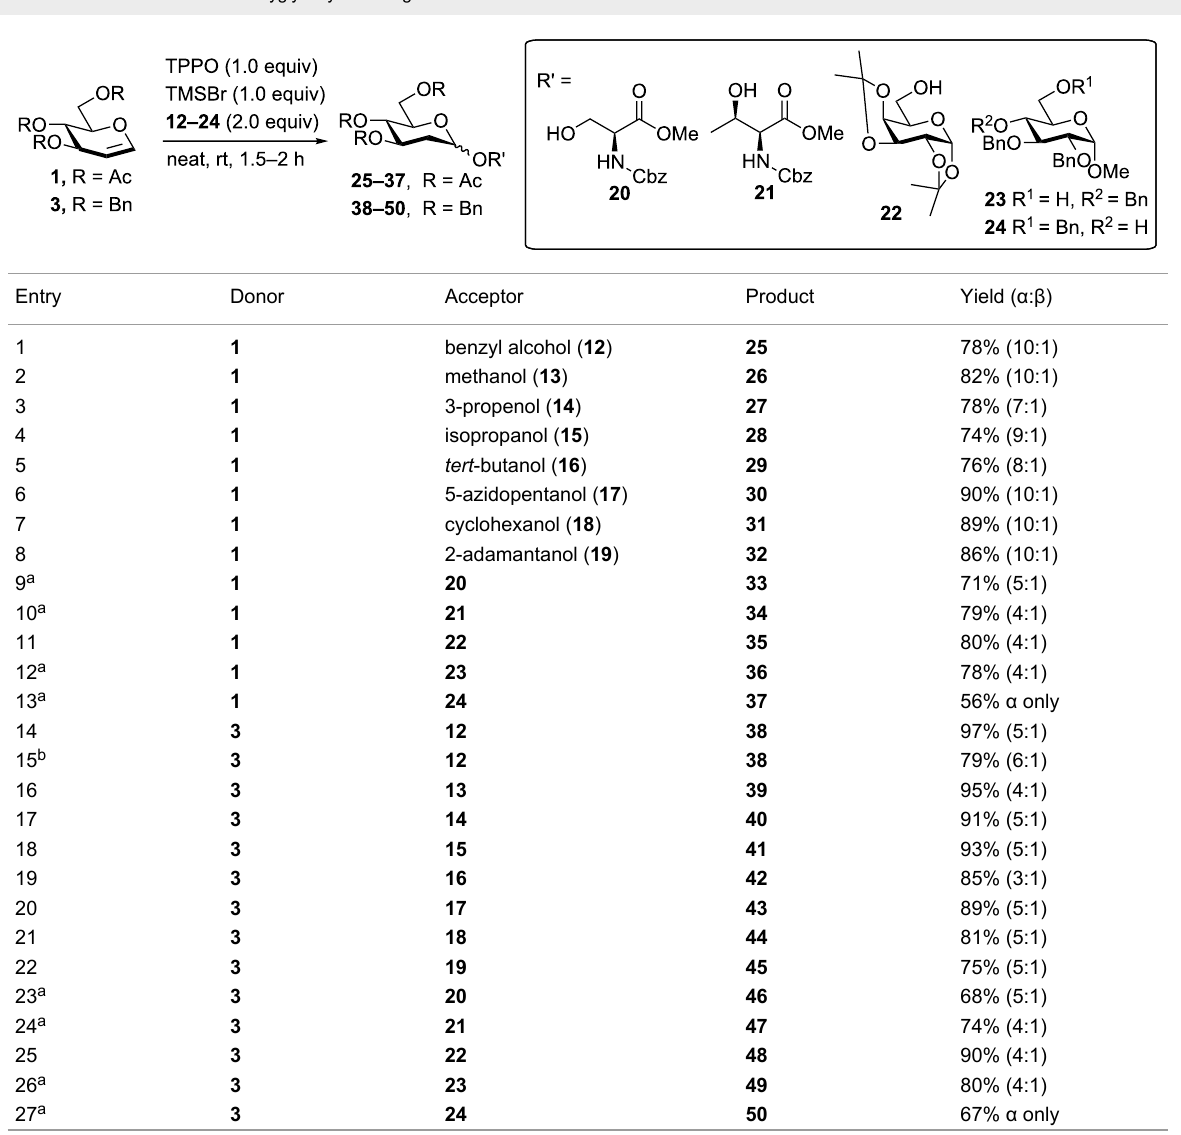
Table 3: TMSBr-mediated 2-deoxyglycosylation of glucals 1 and 3